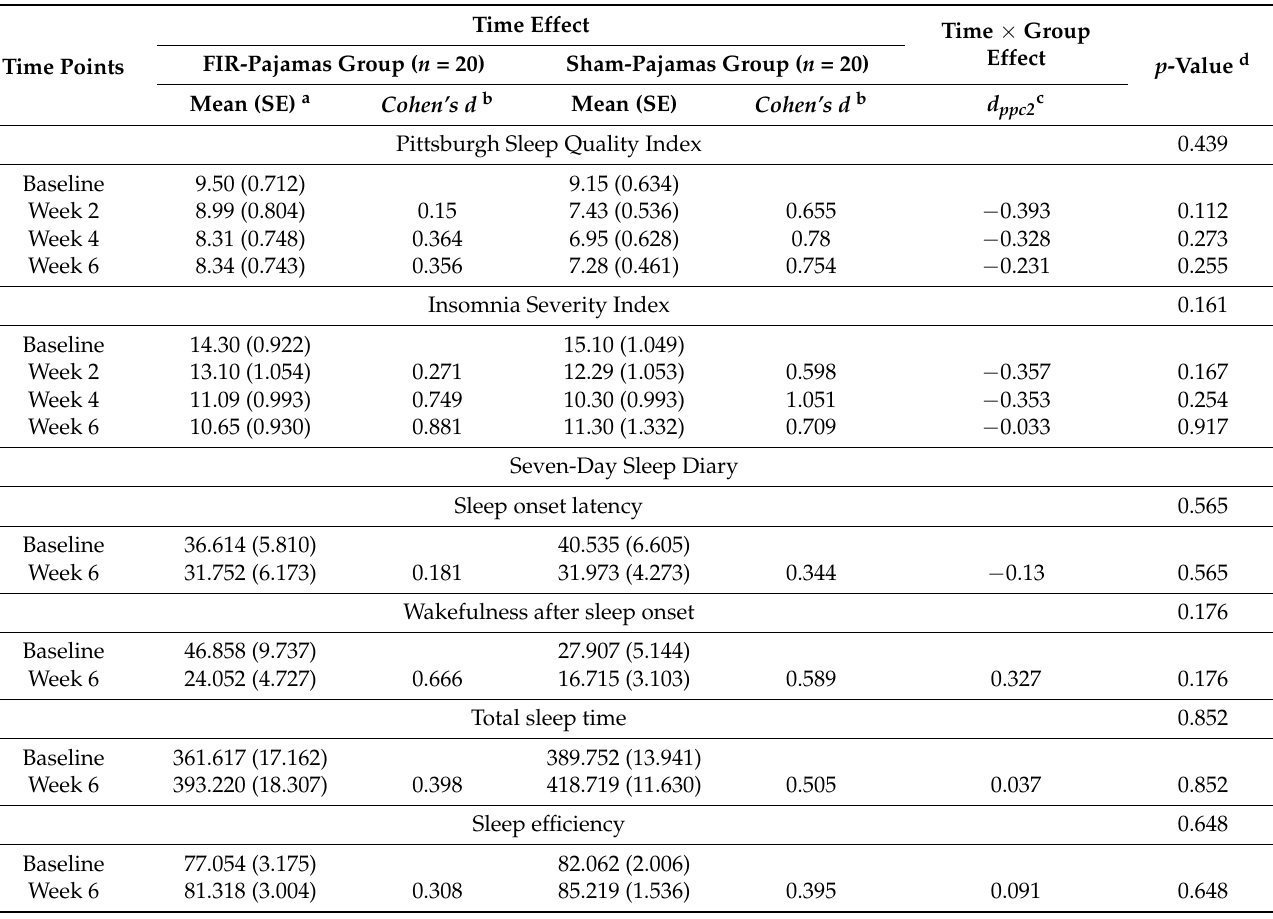
Table 2. Intervention effects on sleepoutcomes across study time-points obtained using the